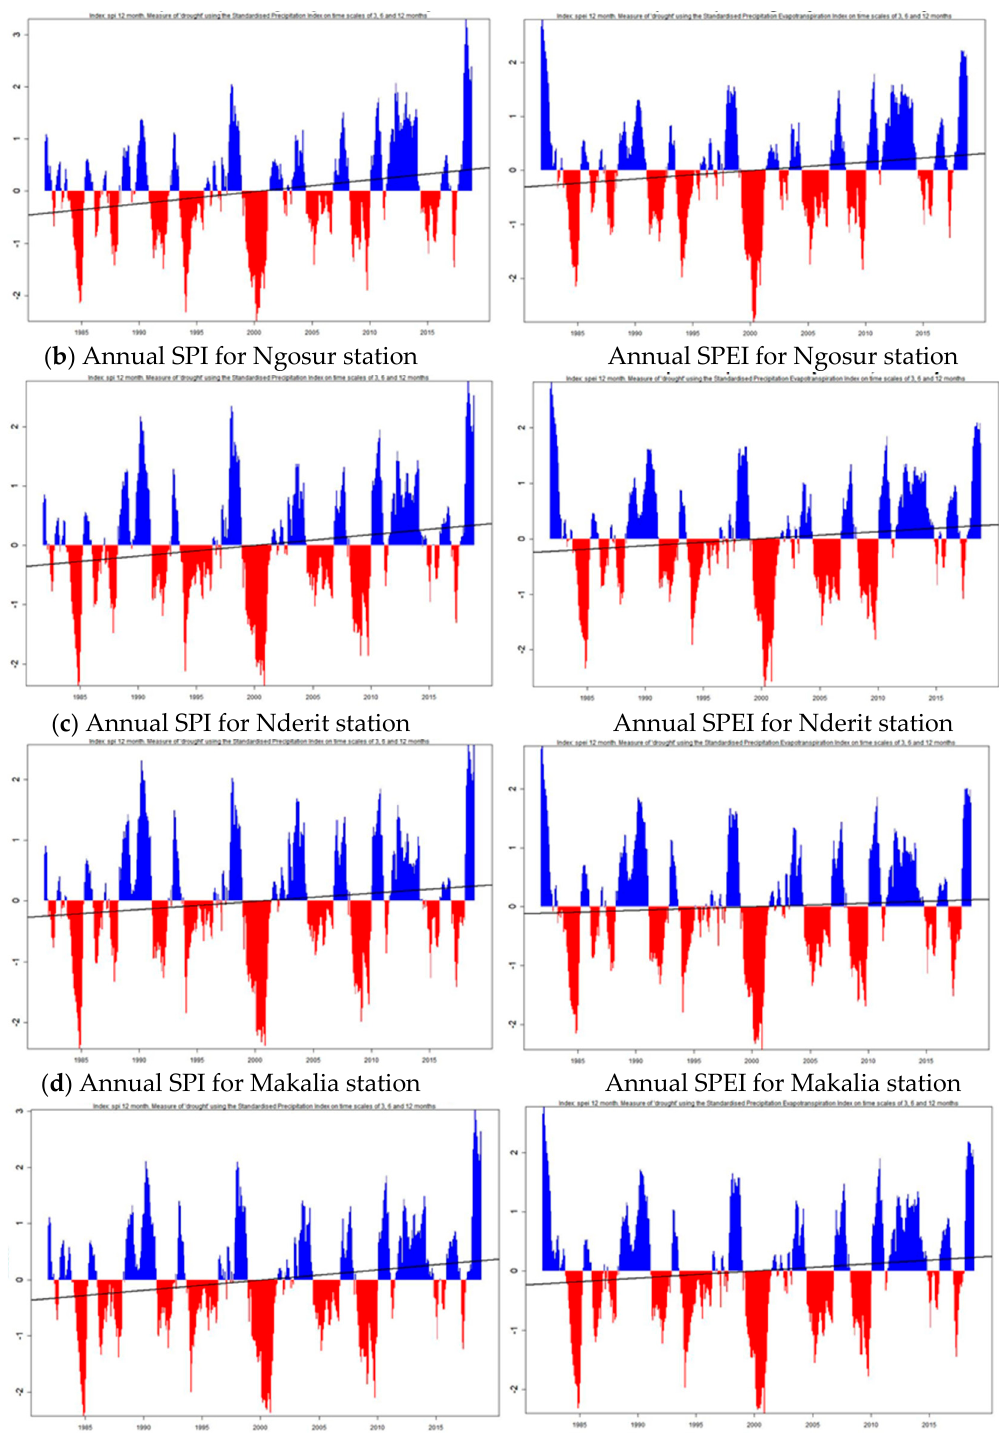
Figure 7. Annual standardized precipitation index (SPI) and standardized precipitation standardized precipitation evaporation index (SPEI) from 1981 to 2018 for ( a ) Egerton station, ( b ) Ngosur station, ( c ) Nderit station, ( d ) Makalia station, and ( e ) Larmudiac station. Table 5. Distribution of wet and dry periods for 12-month SPI for Lake Nakuru catchment from 1981 to 2018 and from 2009 to 2018.